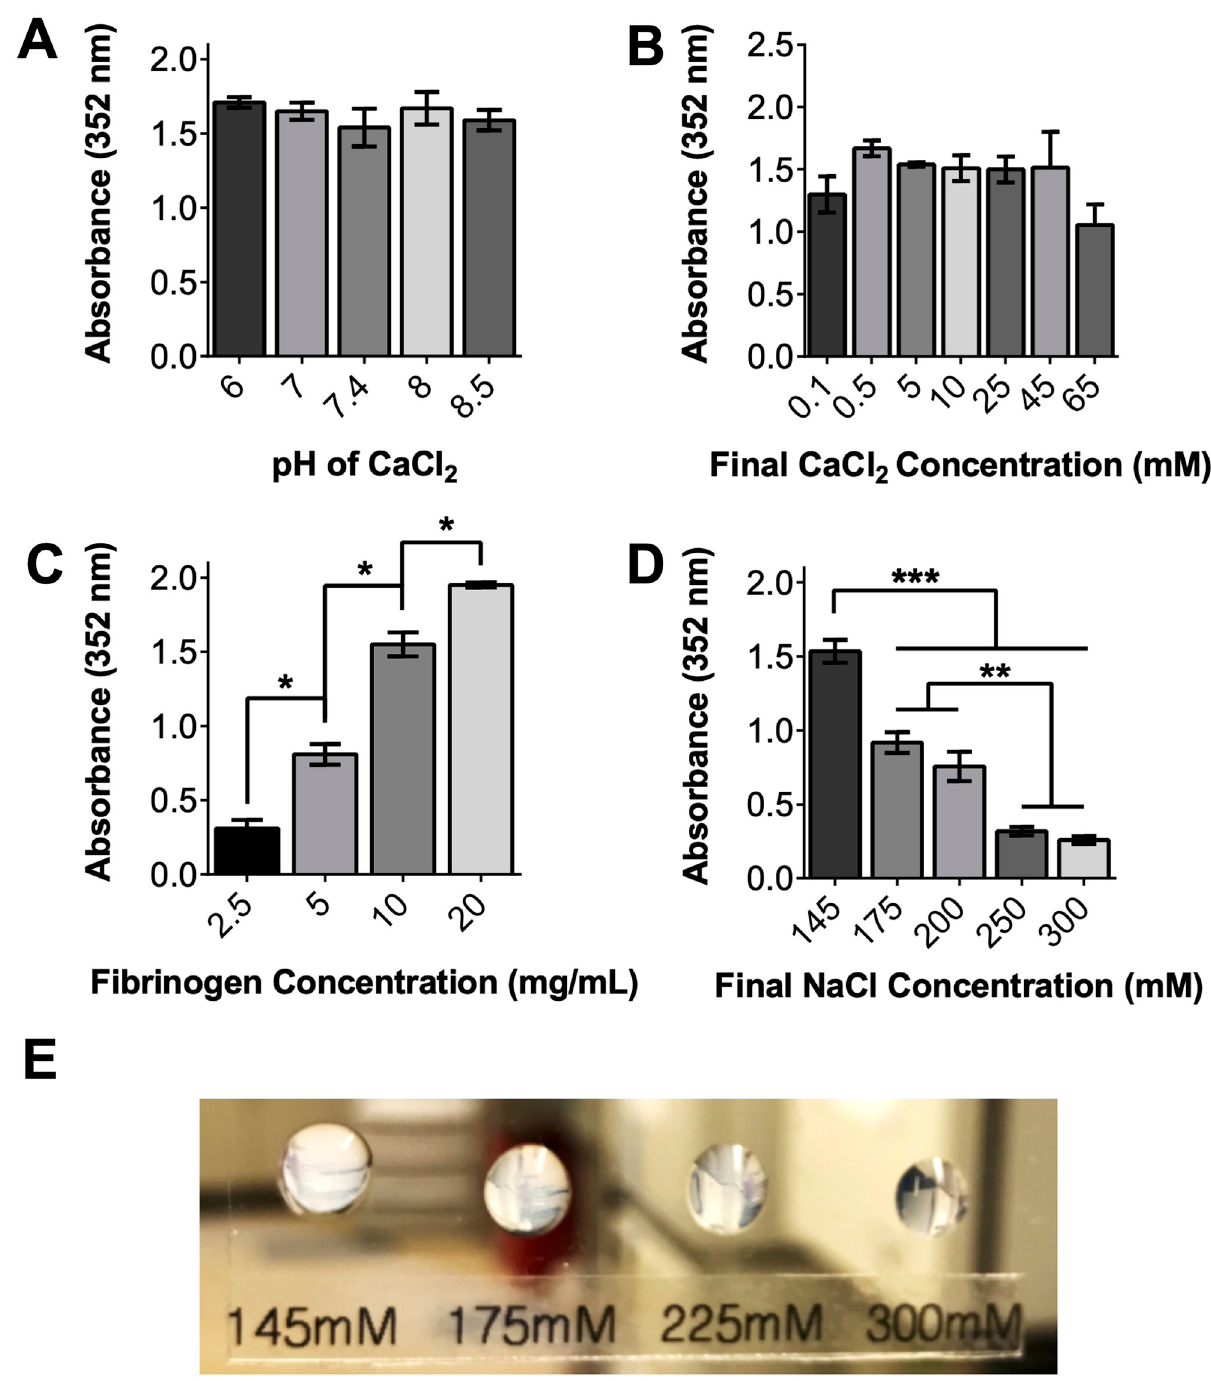
Fig 1. Increasing salinity of fibrinogen solvent with NaCl impacts fibrin opacity. pH (A) and CaCl 2 concentration (B) of gel precursor solutions do not impact gel transparency or morphology. Increasing fibrinogen concentration decreases transparency (C). However, increasing NaCl concentration in fibrinogen solution prior to gelation increases final gel transparency (D, E). For reference, PBS absorbance of 352 nm light is 0.06.